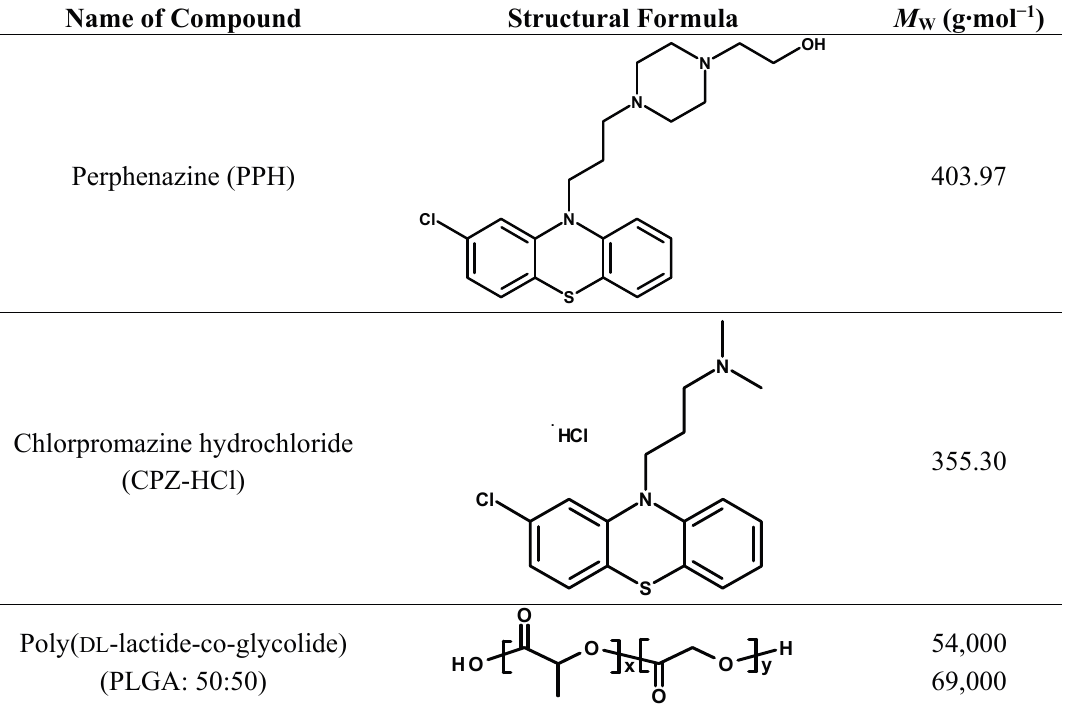
Table 1. Investigated compounds: Name, abbreviation, structure, and molar